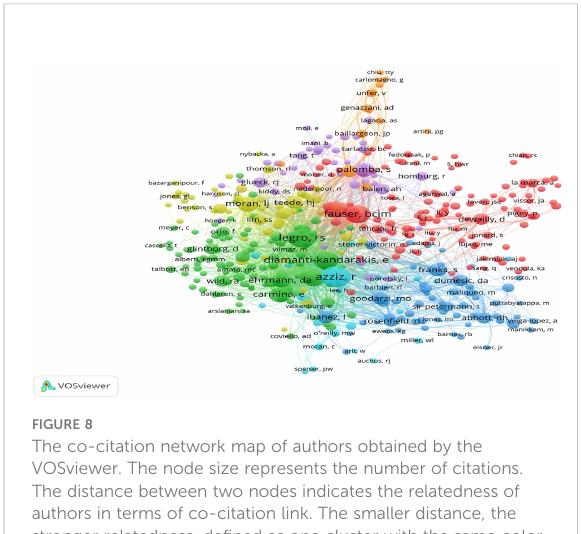
FIGURE 8 The co-citation network map of authors obtained by the VOSviewer. The node size represents the number of citations. The distance between two nodes indicates the relatedness of authors in terms of co-citation link. The smaller distance, the stronger relatedness, de fi ned as one cluster with the same